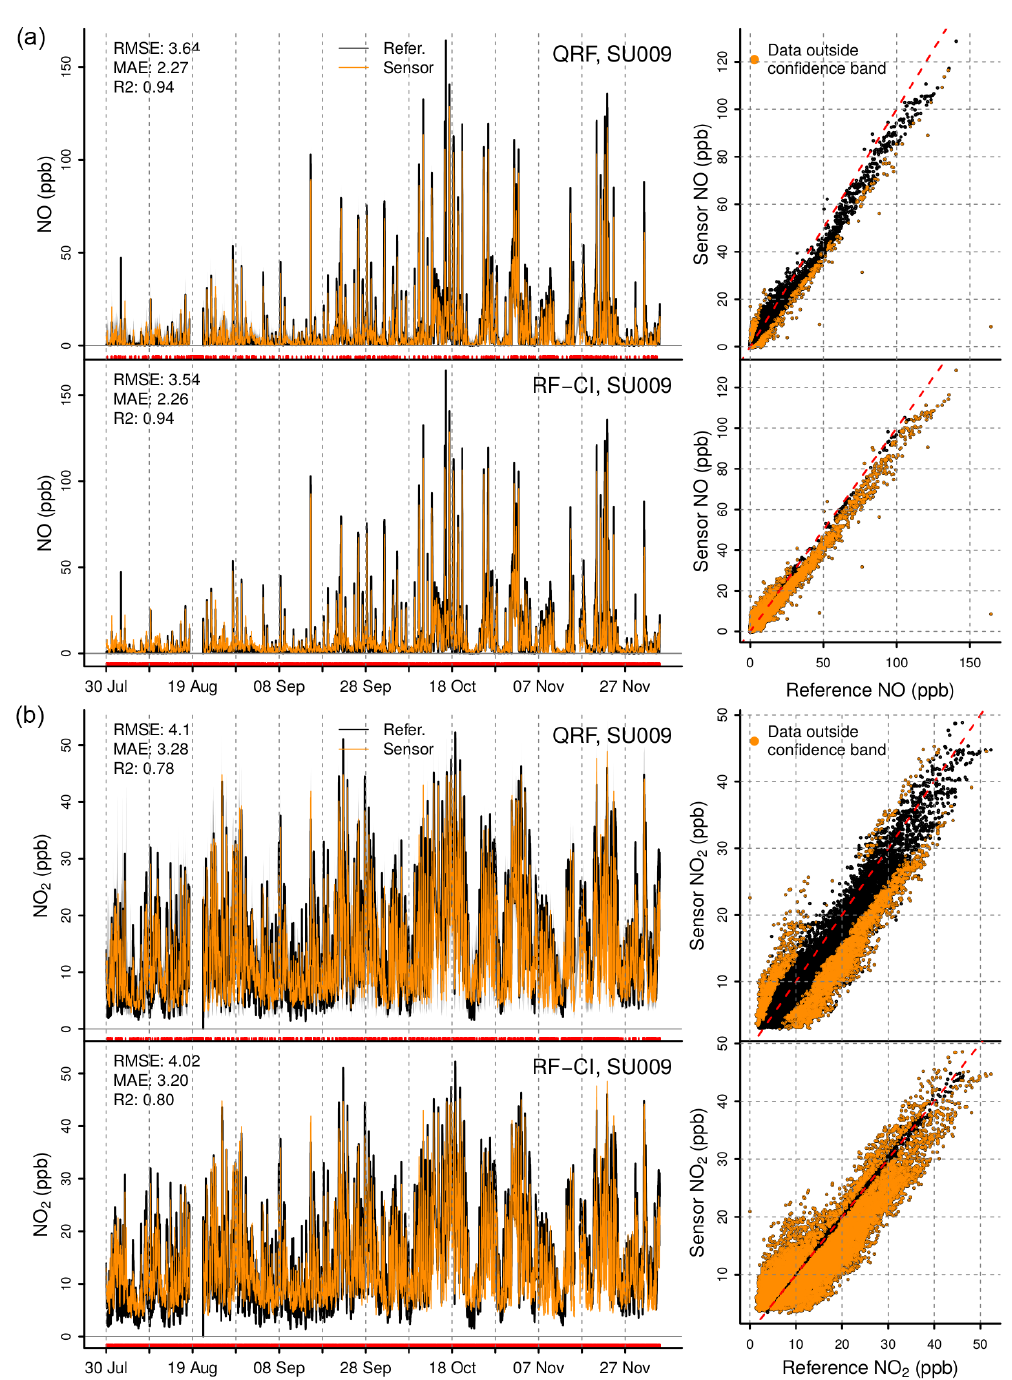
Figure 11. Comparison of QRF and RF-CI estimates of NO (a) and NO 2 (b) by SU009 with observations by reference instruments, at the urban background site Zurich-Kaserne. The grey shaded area indicates either the 5–95% quantiles band (QRF case) or the 95% confidence interval (RF-CI case). 1 : 1 red dashed line is added in the